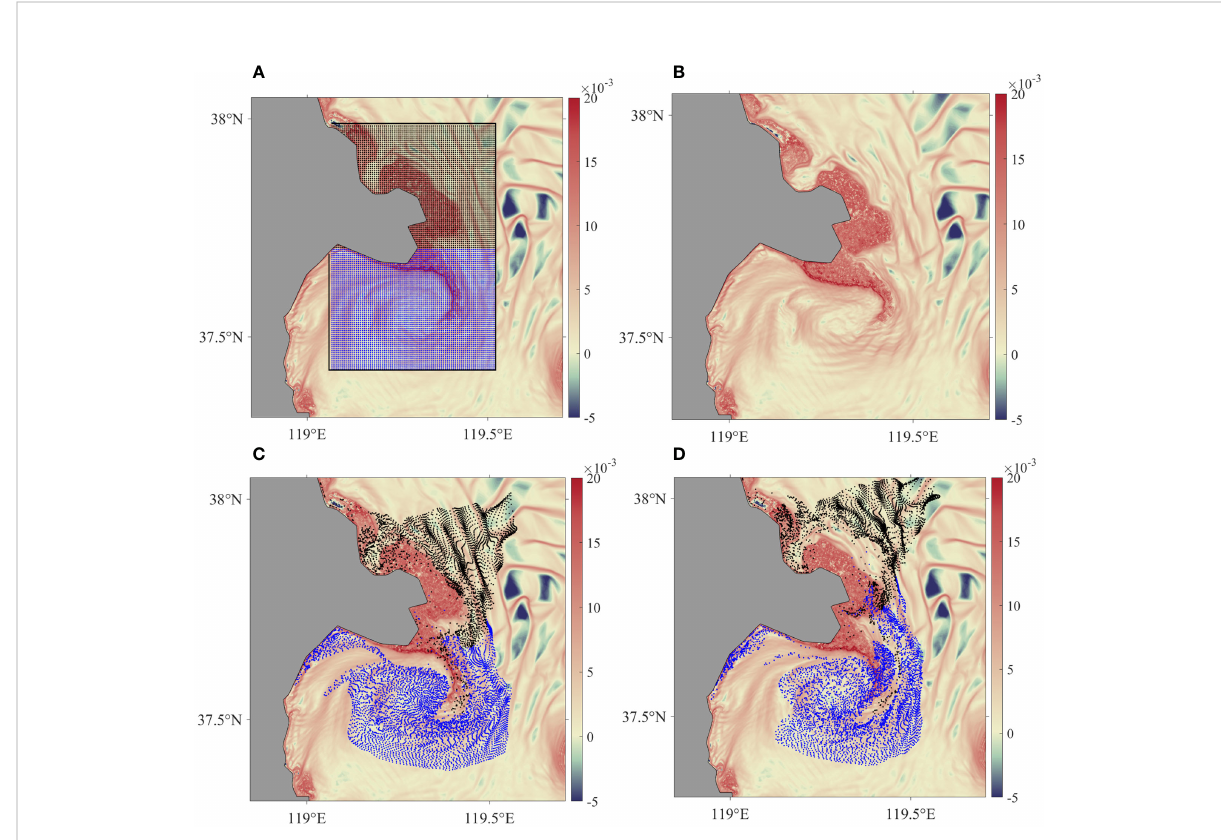
FIGURE 7 Particles were released at low tide and high tide in the study area, respectively, in the backward FTLE fi eld (A) and (B) over a 200-hour time interval. Points with different colors in the box in (A) are the initial positions of the particles released on the north and south sides of the LCS. Particle distribution after 300 h (C) and 500 h (D) of